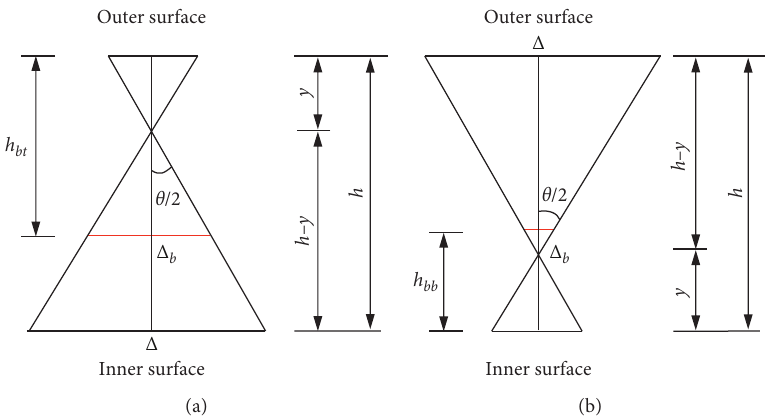
Figure 6: Relationship of joint opening angle and maximum opening value for (a) PBM and (b) NBM.